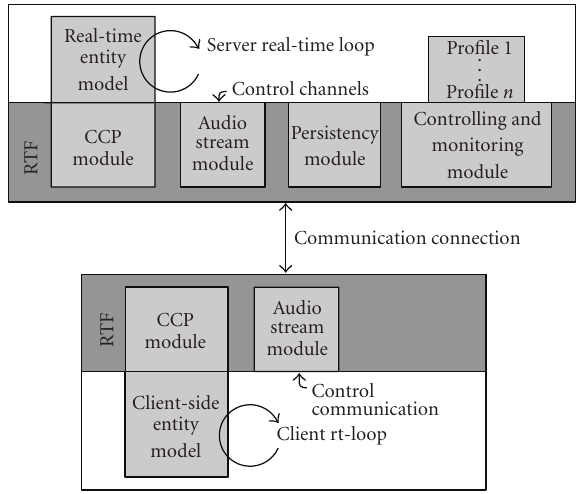
Figure 5: Modular approach of